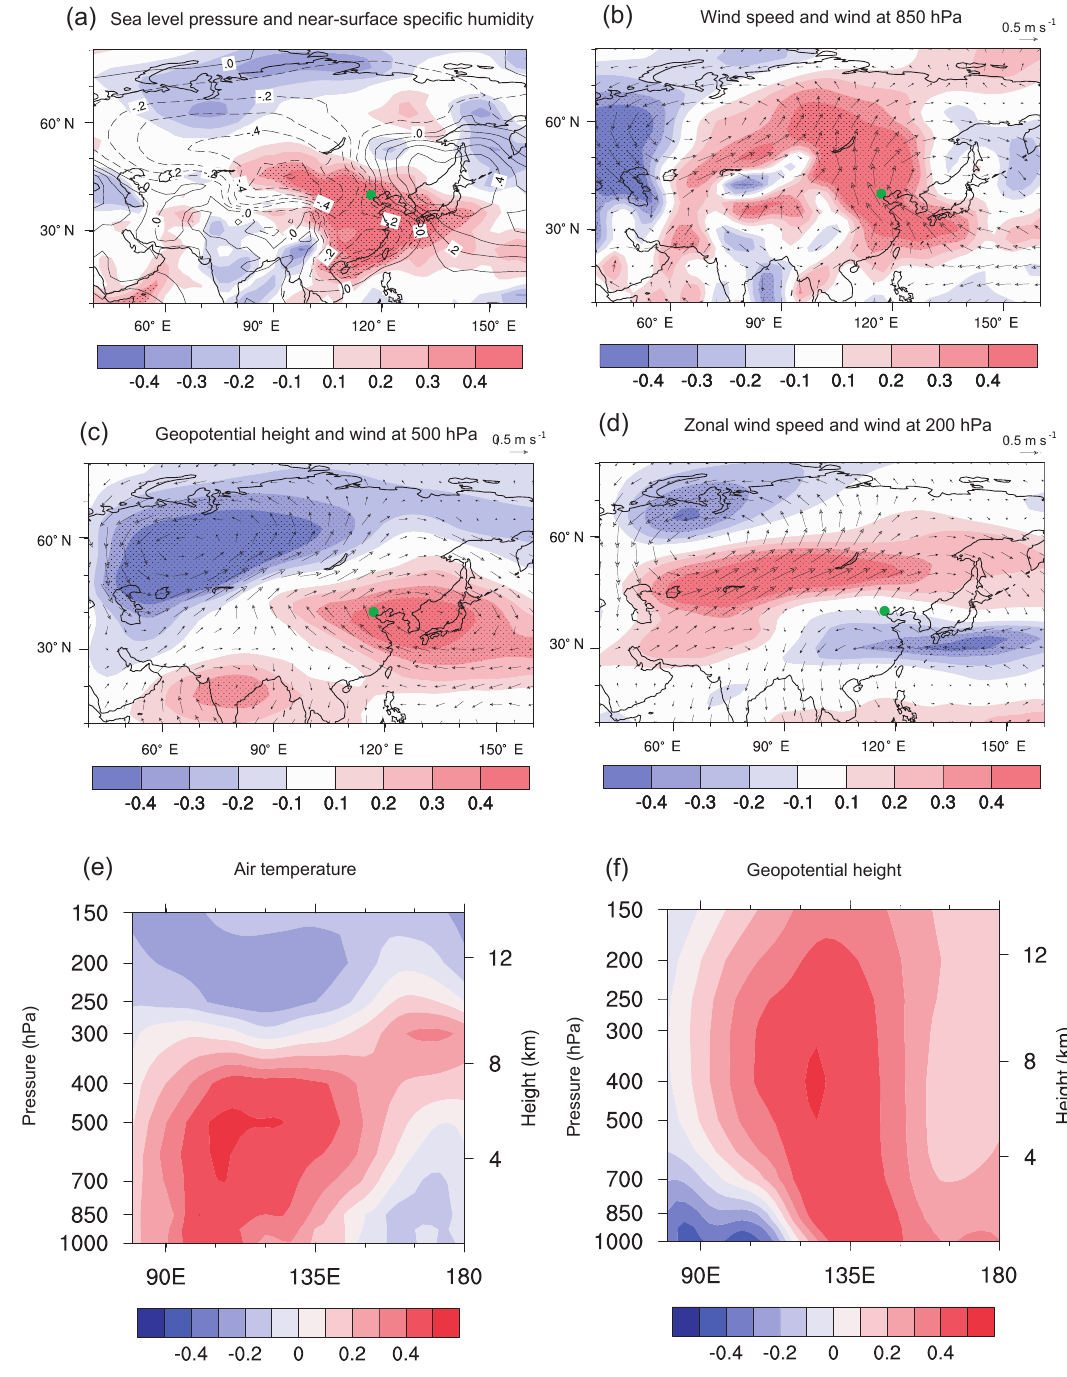
Figure 3. The correlation coefficients between the number of persistent haze days and (a) specific humidity at 1000hPa (shading) and sea level pressure (contour); (b) composite wind speed (shading) and the composite wind (vectors) at 850hPa; (c) geopotential height (shading) and the composite wind (vectors) at 500hPa; (d) zonal wind speed (shading) and the composite wind (vectors) at 200hPa; (e) vertical profile of air temperature at 40 ◦ N; and (f) vertical profile of geopotential height at 40 ◦ N in winter from 1980 to 2016 based on the monthly NCEP/NCAR reanalysis data. The linear trend is removed before calculating the correlation. The black dots indicate significant changes at the 0.05 level using the t test. The green dot denotes the location of Beijing (40 ◦ N, 117 ◦